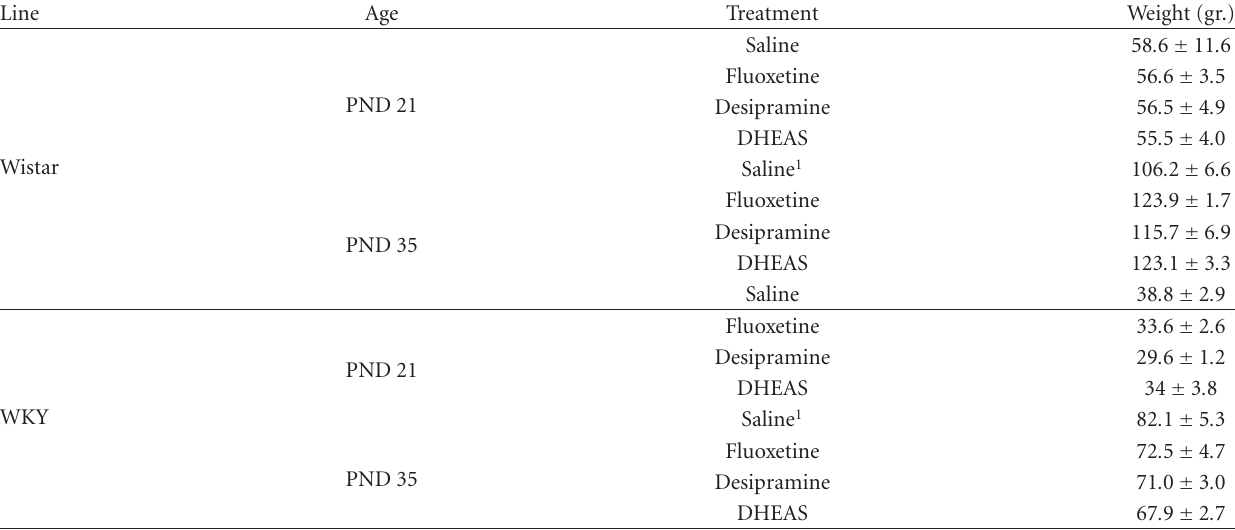
Table 2: Weight in grams (mean ± SEM) of 21-day-old and 35-day-old Wistar and WKY rats in the di ff erent treatment groups (DHEAS, desipramine, fluoxetine,